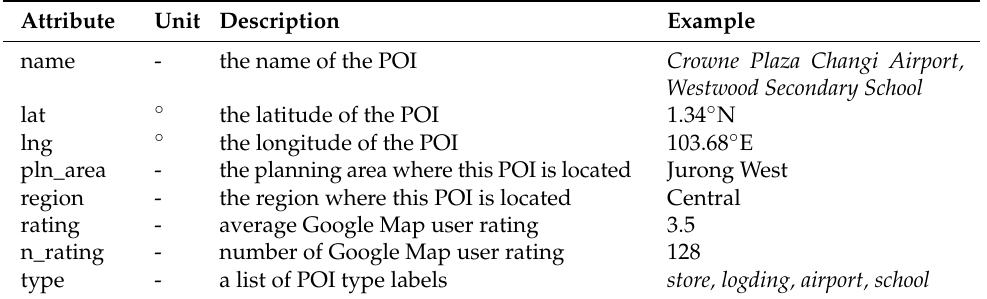
Table 4. Attribute list of the POI